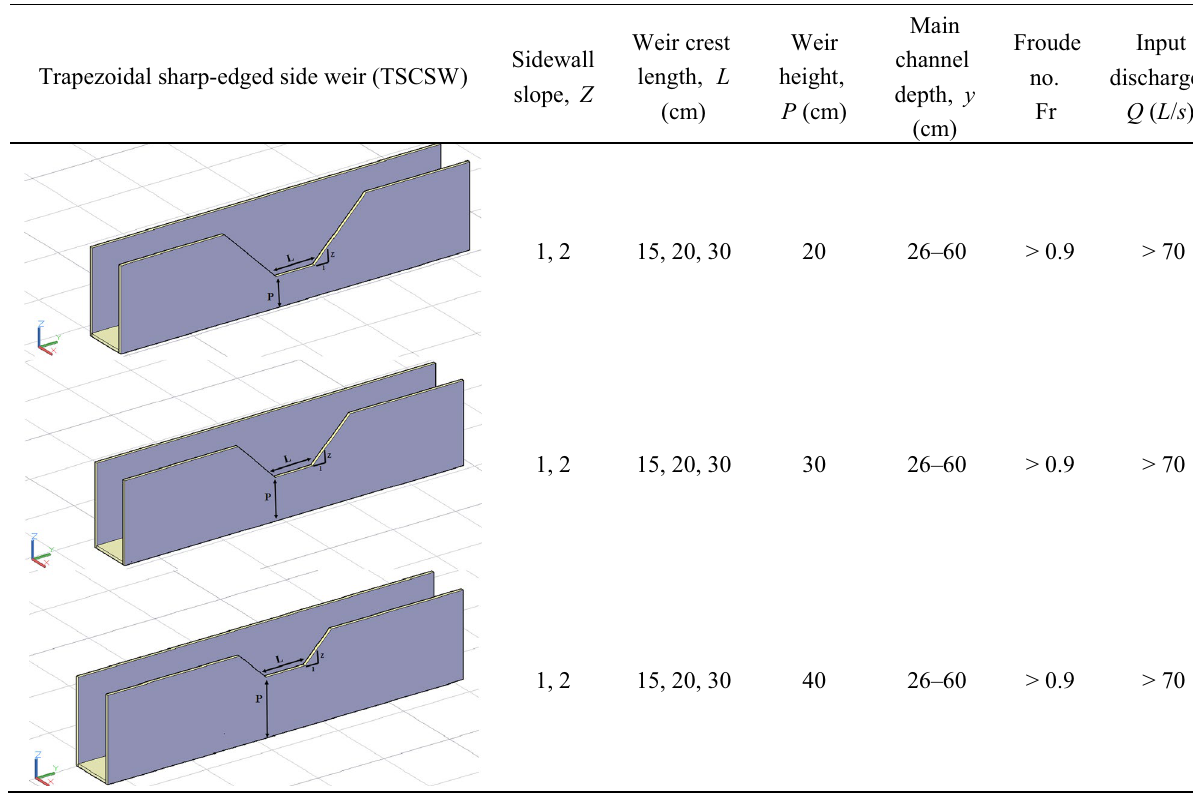
Table 1 Geometric parameters of the present study